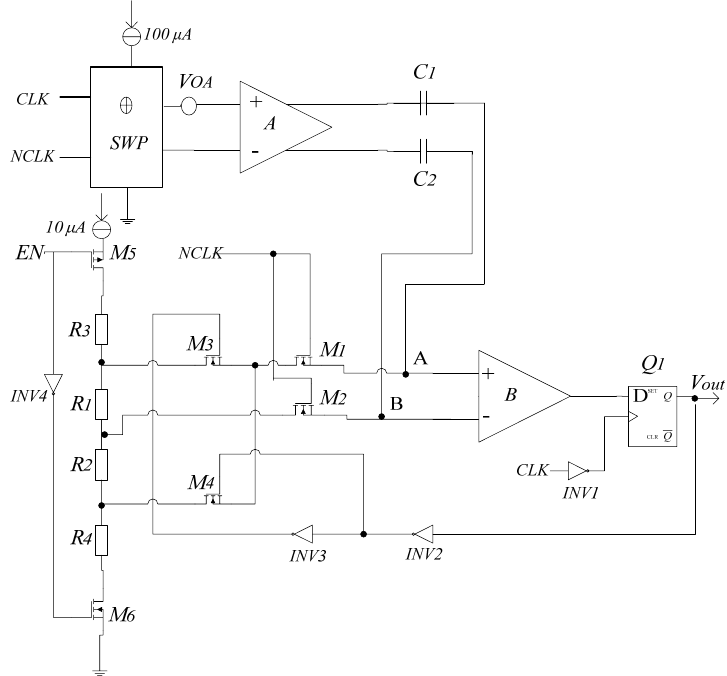
Figure 4. Signal conditioner of the digital Hall